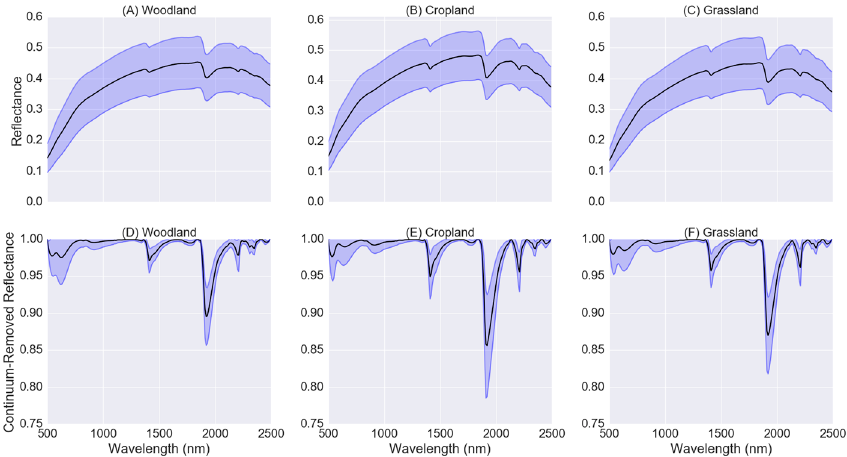
Figure 3. ( A – C ) are mean soil reflectance spectra (black lines) and standard deviations (blue lines, lower and upper boundaries) for soil samples from woodland, cropland, and grassland; ( D – F ) are mean soil continuum-removal spectra (black lines) and standard deviations (blue lines, lower and upper boundaries) for soil samples from woodland, cropland, and grassland. Values are given in reflectance ( A – C ) and normalized continuum-removal values ( D – F ).